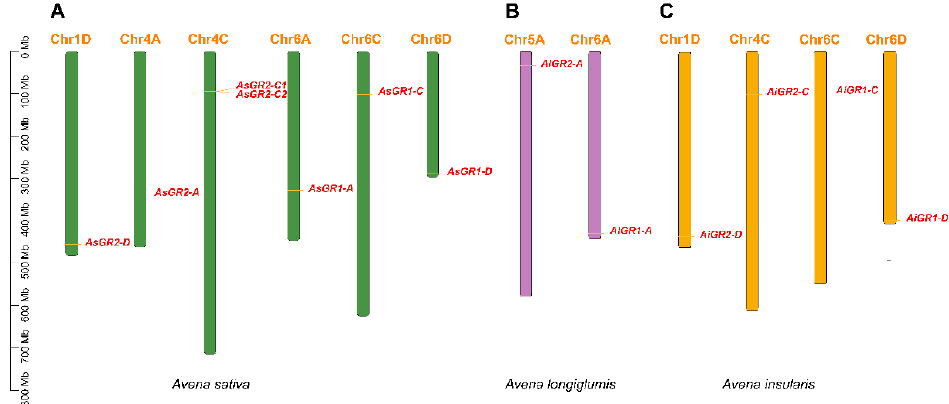
Figure 1. Chromosomal mapping of GR genes in A. sativa ( A ), A. longiglumis ( B ), and A. insularis ( C ). The chromosome number is denoted on the top of each chromosome. The scale is marked in megabases (Mb).